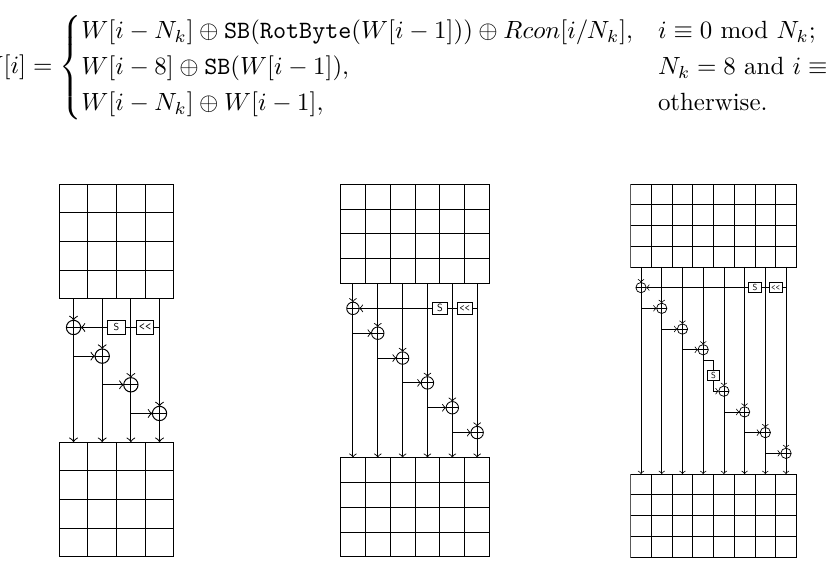
Figure 2: Round functions of key-schedules of AES -128, AES -192, and AES -256 [Jea16] The i -th round key is the concatenation of 4 words W [4 i ] k W [4 i +1] k W [4 i +2] k W [4 i + 3]. RotByte is a cyclic shift by one byte to the left, and Rcon is the round constant,